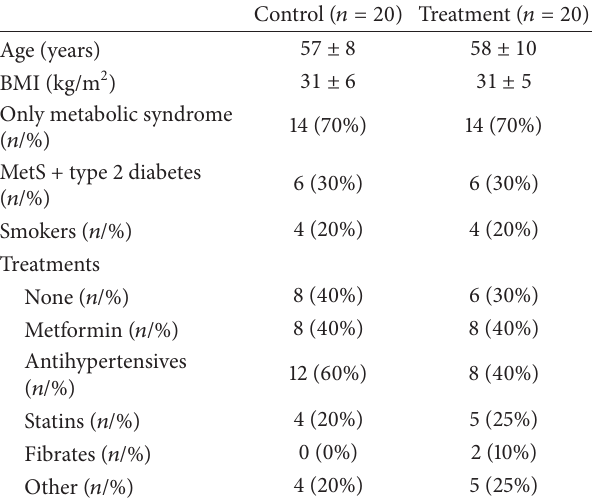
Table 1: Demographic characteristics of patients at